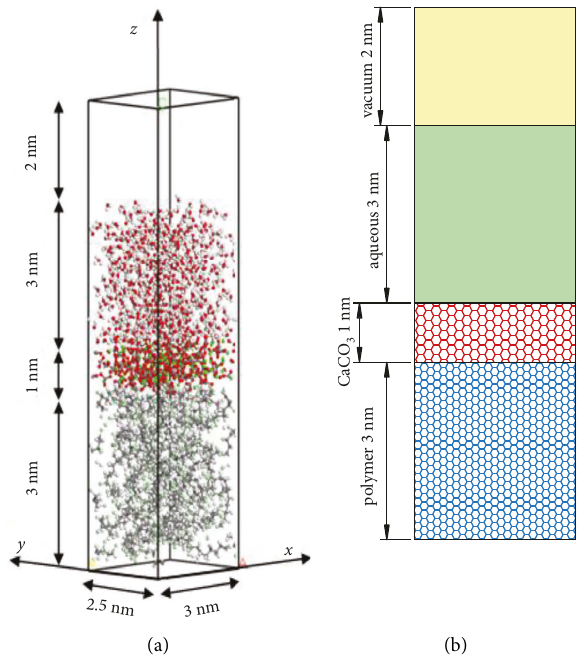
Figure 5: Schematic diagram of molecular model. (a) Molecular dynamics model. (b) Regional distribution.